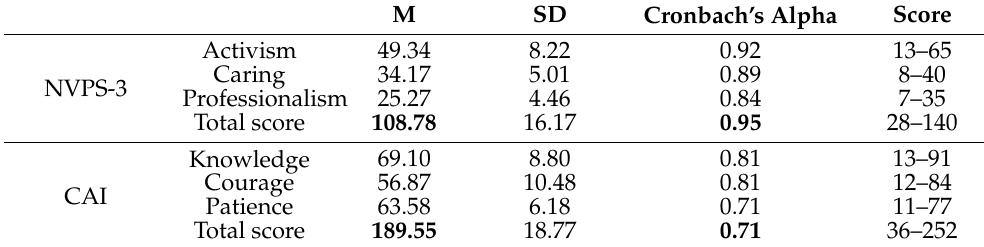
Table 2. Respondents’ overall results on the CAI and NPVS-3 scales.